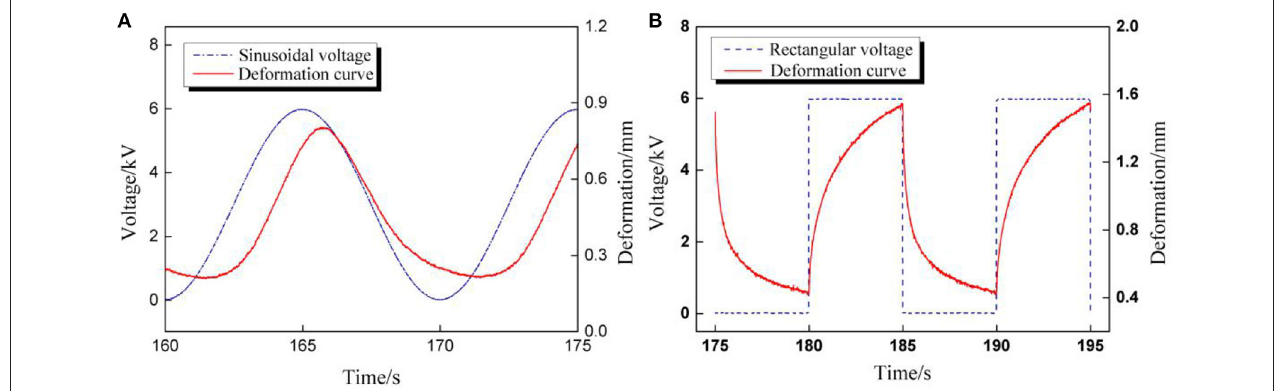
FIGURE 10 | The comparisons of voltage and deformation curves excited by cyclic voltages. (A) Sinusoidal voltage; (B) Rectangular voltage.